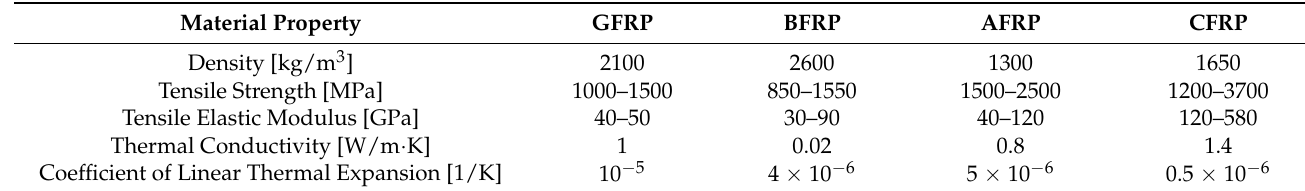
Table 1. The basic properties of composite